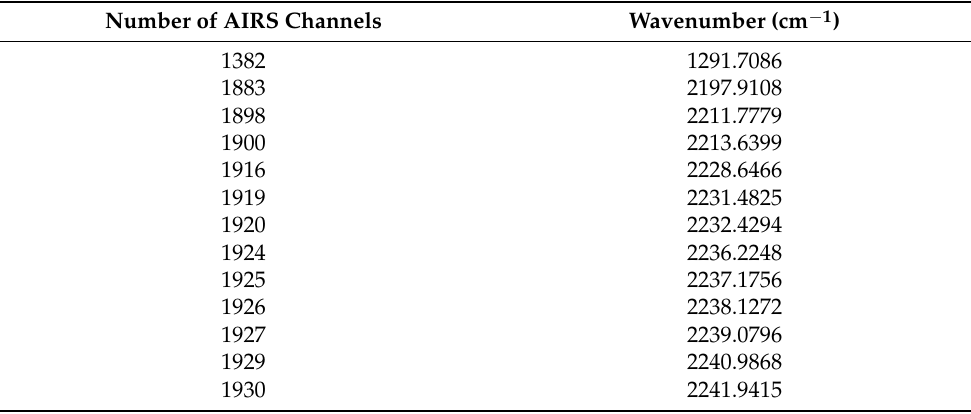
Table 2. The selected channels for N 2 O retrieval using the modified OSP